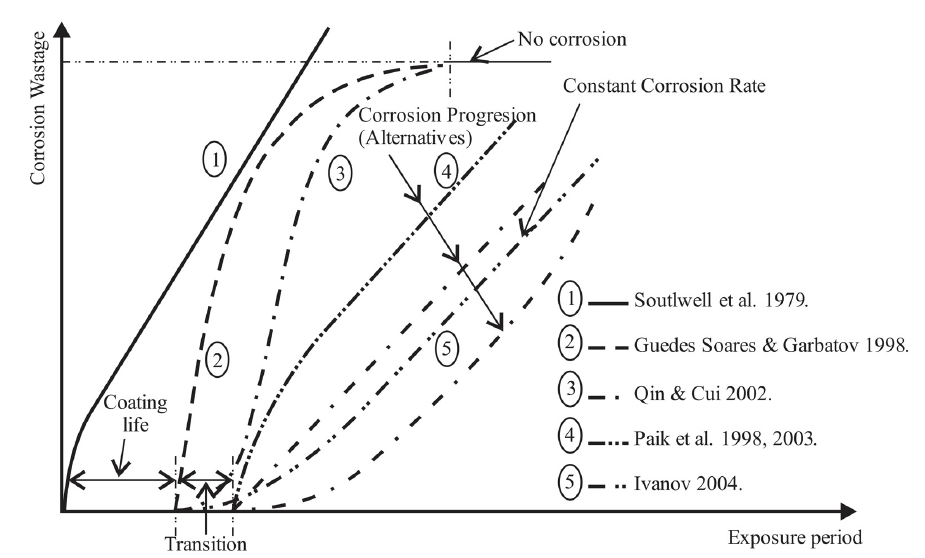
Figure 1. Review of the most prominent models of corrosion loss